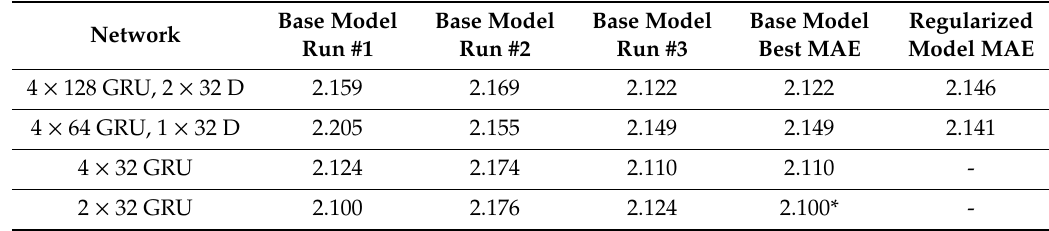
Table 5. Summary of results (energy consumption data range is ~40–170; * performance of best recurrent neural networks model).